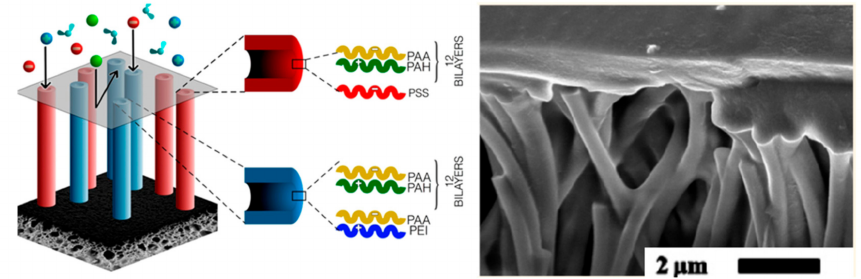
Figure 24. ( Left ) Schematic of the mixed mosaic membranes (MMMs) prepared using LBL assembly. Cationic (blue) and anionic (red) nanotubes are aligned vertically on a support membrane, and a sealing layer is applied to prevent convective flow through the interstitial regions between the nanotubes. Dissolved ions (blue and red spheres) can permeate through nanotubes lined by moieties with the opposite charge, which results in higher ionic permeabilities compared to the permeability of neutral molecules (green spheres). Anionic and cationic polymeric nanotubes were prepared by terminating the multilayer assembly with negatively charged poly(styrenesulfonate) and positively charged polyethylenimine, respectively. ( Right ) Scanning electron micrographs of MMMs. Reproduced with permission from Reference